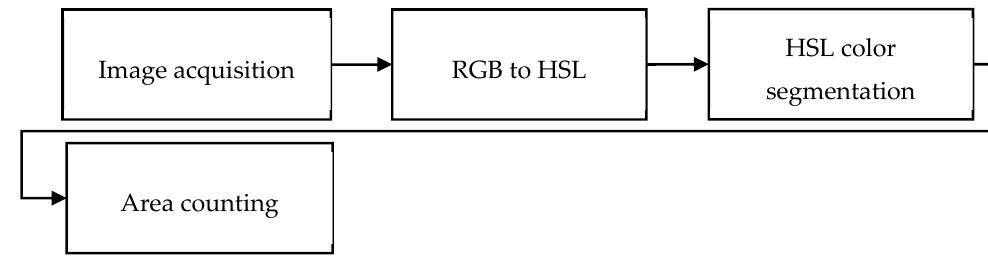
Figure 3. The flow chart of the leaves-occupied area counting algorithm. Figure 3 The flow chart of the leaves-occupied area counting algorithm. Figure 3 The flow chart of the leaves-occupied area counting algorithm.